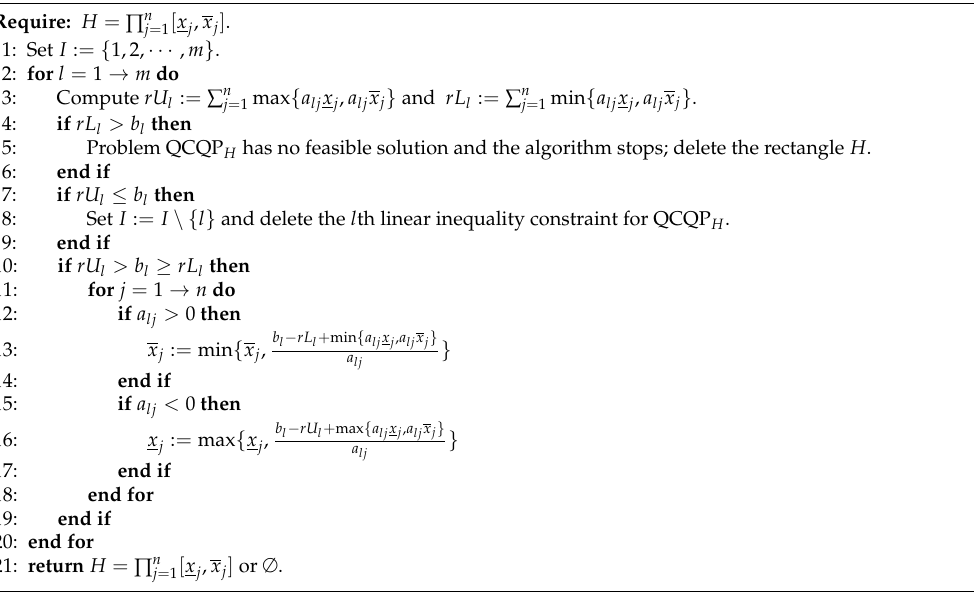
Algorithm 1 Rectangle-Reduction Technique based on Linear